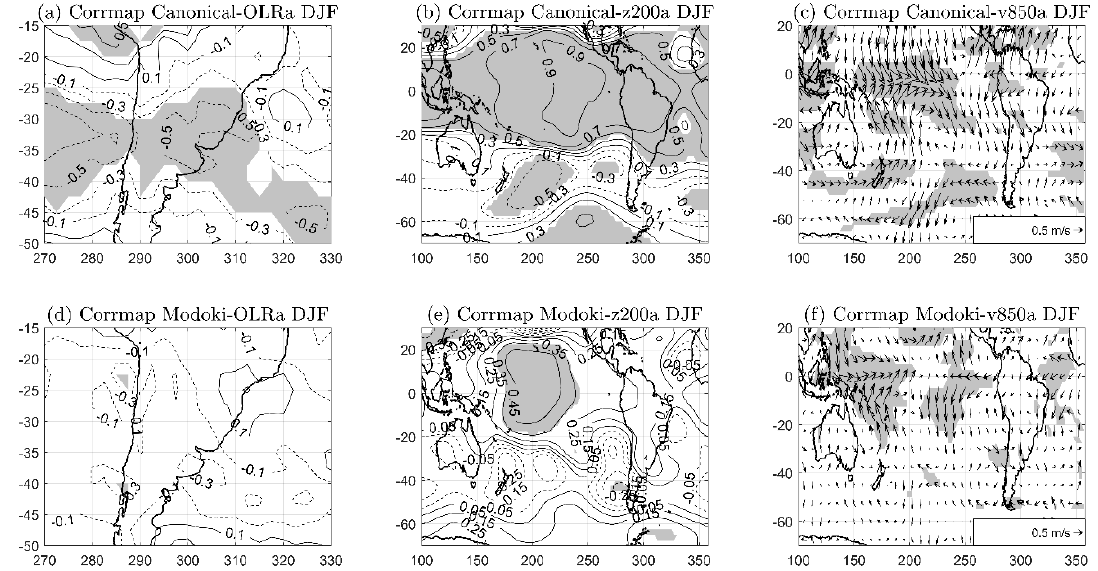
Figure 2. Correlation maps for Canonical El Niño (first row) and El Niño Modoki (second row). Correlation of outgoing longwave radiation (OLR)a ( a , d ); z200a ( b , e ); and v850a ( c , f ). Shaded regions exceed the 95% level of confidence from a two-tailed t -test. OLRa units: W / m 2 , z200a units: m and v850 units: m / s. Results from reanalysis data.